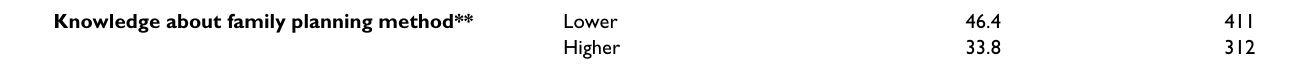
Table 2: Pregnancy intention by selected characteristics Demographic